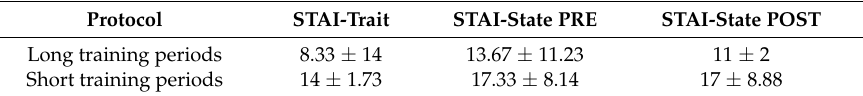
Table 1. State-Trait Anxiety Inventory (STAI)-Trait, STAI-State during the first session of the training (PRE) and STAI-State during the last session of the training (POST). Data are presented as mean value ± standard deviation.